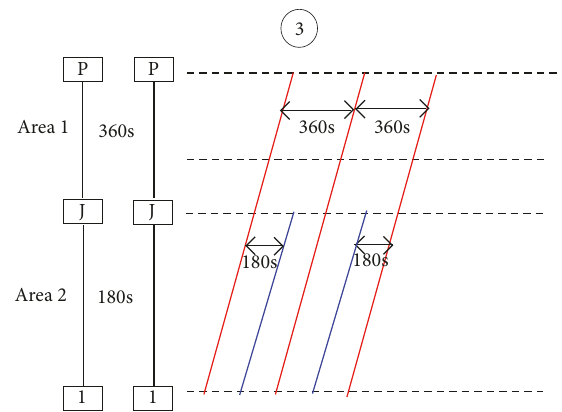
Figure 6: Both passenger demands in areas 1 and 2 can be